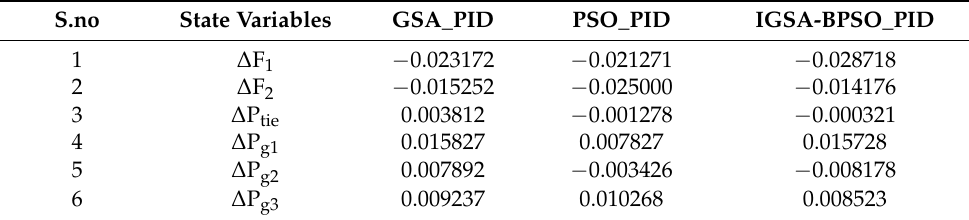
Table 9. Overshoot values (s) for different optimization techniques (O.T.) on system state variables– CVT.